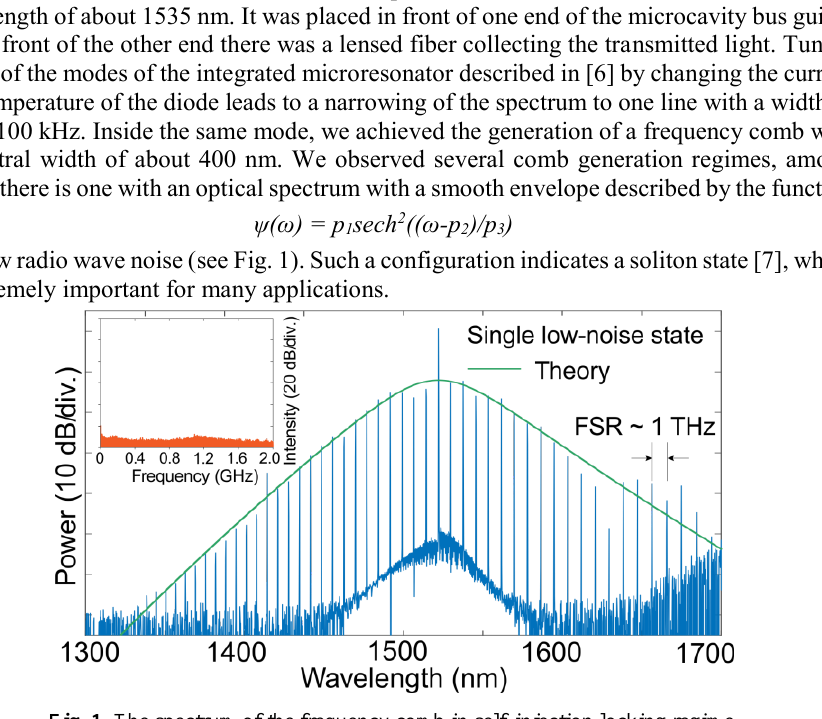
Fig. 1. The spectrum of the frequency comb in self-injection locking